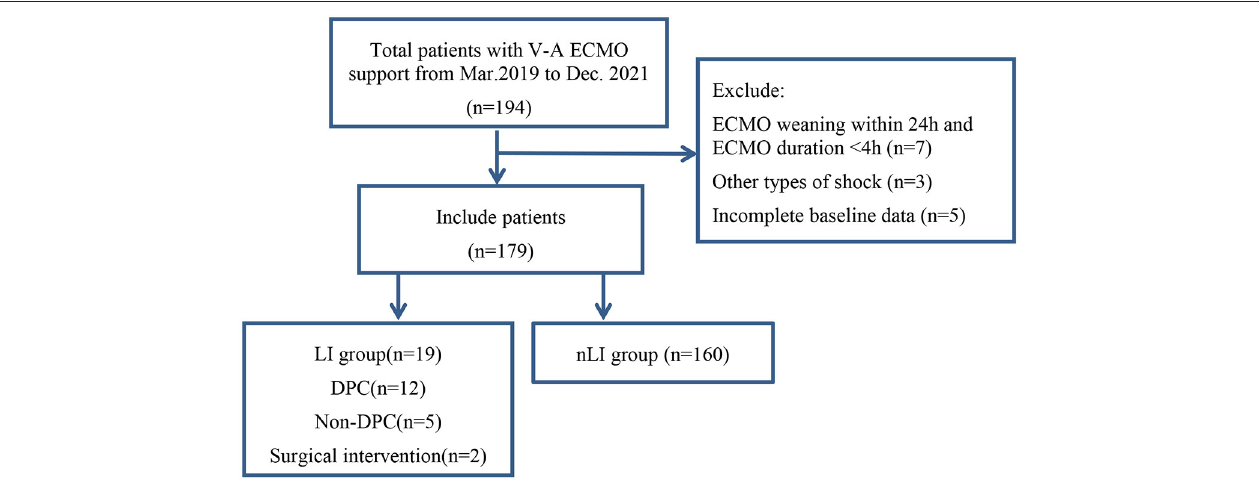
FIGURE 1 | Flow chart of patient cohorts. V-A ECMO, veno-arterial extracorporeal membrane oxygenation; DPC, distal perfusion cannula; LI, limb ischemia complications group; nLI, non-limb ischemia complications